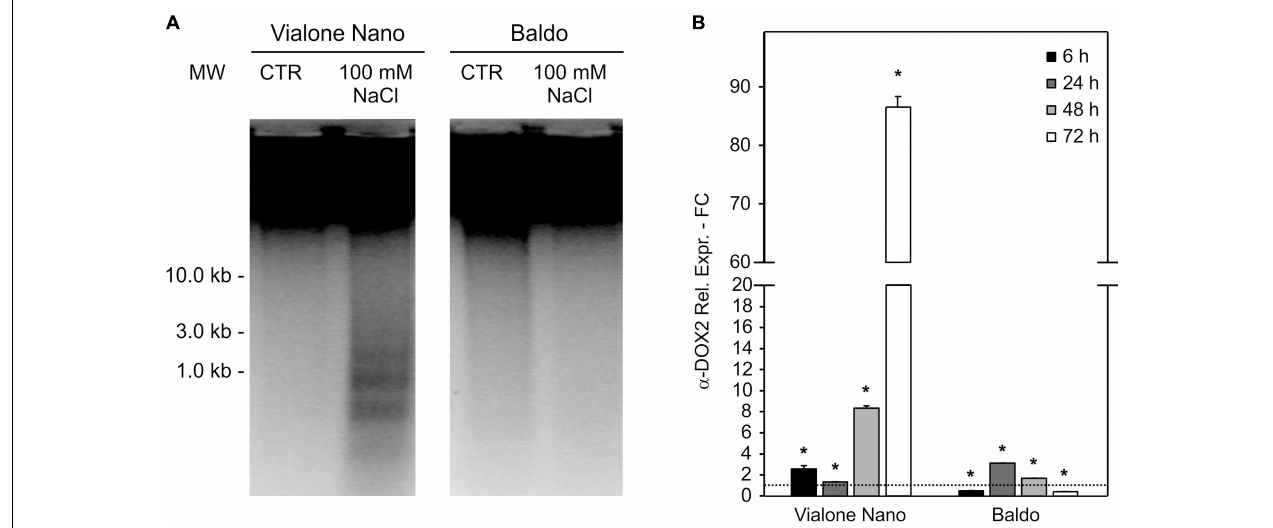
FIGURE 2 | Programmed cell death features in salt sensitive VN and B resistant cells. Oligonucleosomal DNA fragmentation (A) and high expression of a-DOX2 (B) are present only in dying cells. Values represent the mean ± SE of three independent experiments. Asterisks indicate significative differences with respect to control samples ( p < 0.01, Wilcoxon–Mann–Whitney’s test, Marx et al.,